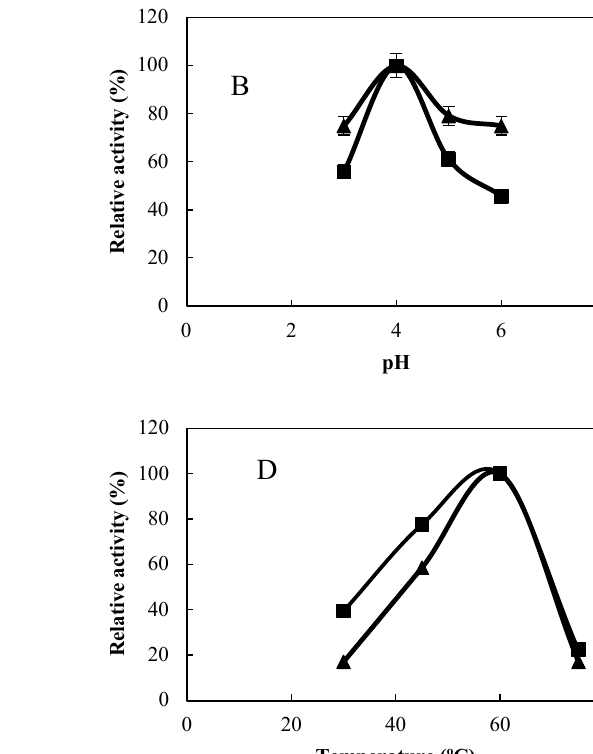
Figure 6. Kinetics of grapefruit juice debittering catalyzed by free enzyme: ⯁ Limonin; ● Naringin; ∎ Prunin; ⯅ Naringenin . ⯅ p ⯁ Before applying immobilized biocatalysts, the adsorption capacity of the supports was evaluated (Figure 7). Both enzyme ‐ free supports allowed for the adsorption of all bitter compounds; however, the best performance was observed with BGA, which